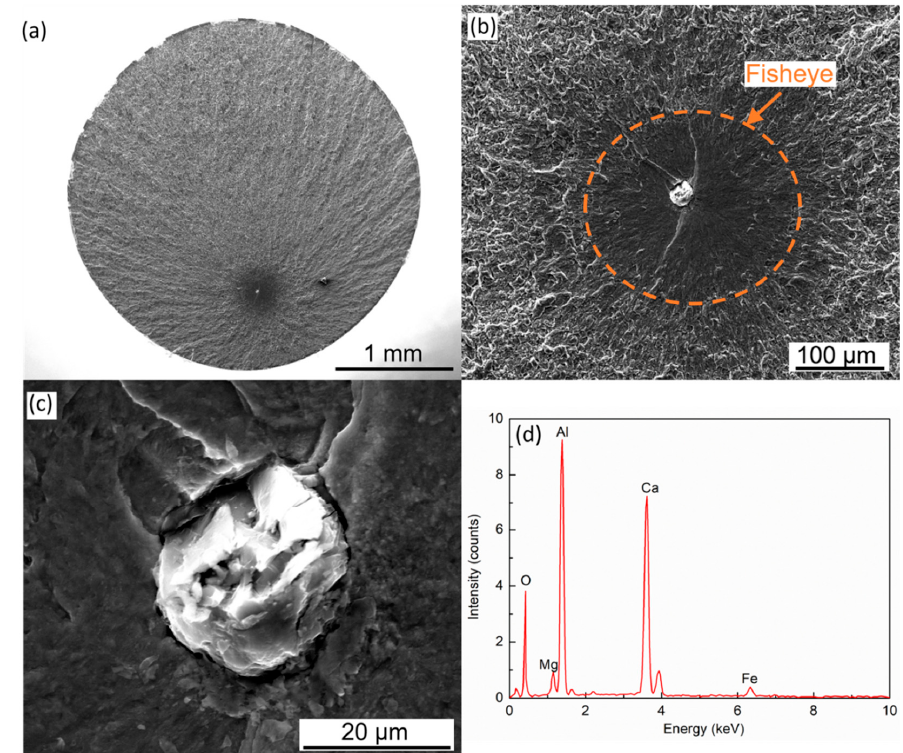
Figure 7. Typical morphologies of the fatigue crack initiated from a spinel inclusion: ( a ) Fracture surface; ( b ) fish eye structure; ( c ) inclusion in the crack initiation site; ( d ) EDS analysis of the inclusion.